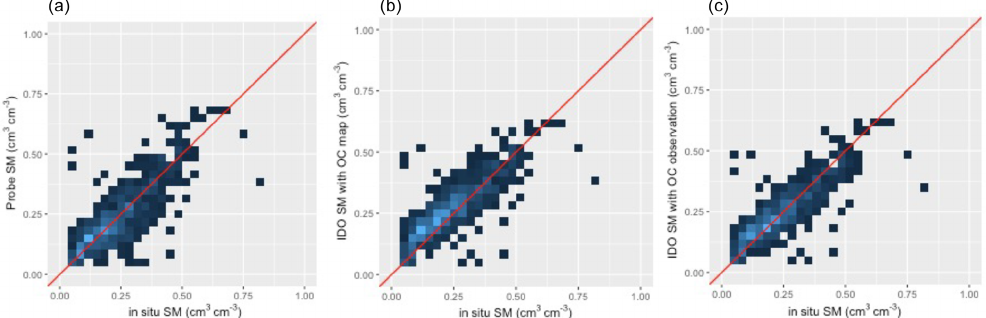
Figure 6. Performance of soil moisture probe algorithms in terms of scattering degree to the gravimetric measurements ( x axis): soil moisture estimates ( y axis) using (a) a third-order polynomial approach (Seyfried and Murdock, 2004; Bell et al., 2013), (b) the proposed IDO with the variational soil organic matter (SOM) sampled from the SoilGrid250m map (Hengl et al., 2017), and (c) the same algorithm but with SOM measured from SMAPVEX12 (Manns and Berg, 2014).